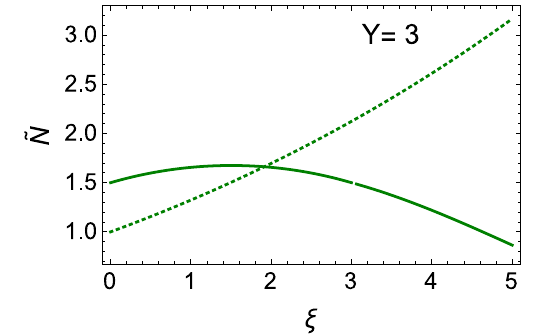
Fig. 8 Comparison of the NLO calculation(solid line) with the LO estimates (dotted line). ¯ α S = 0.2. Y = 3